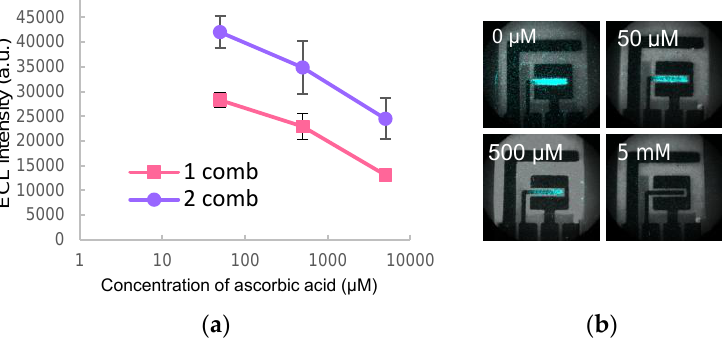
Figure 4. ( a ) ECL quenching effect of ascorbic acid; ( b ) Images of the quenching of luminol ECL by different concentrations of ascorbic acid (shown in top left of